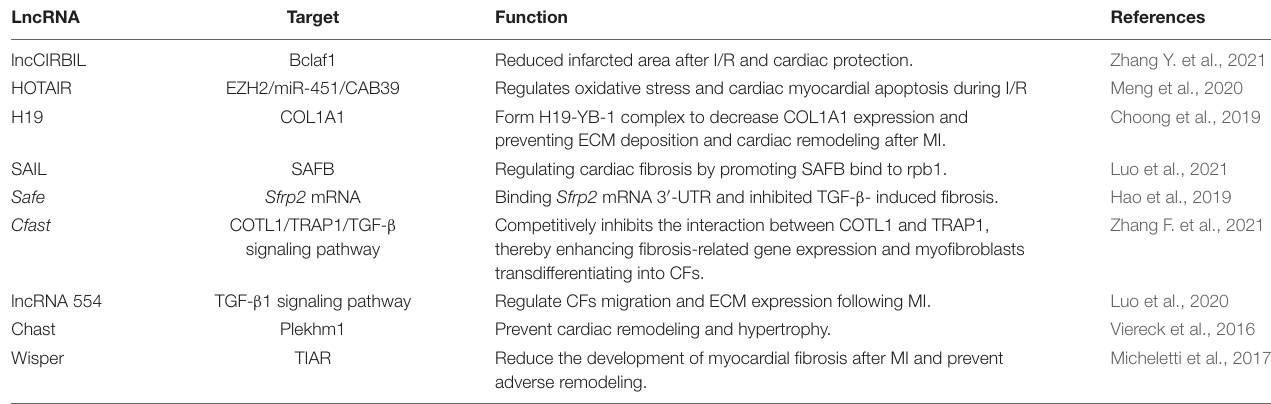
TABLE 3 | LncRNAs in secondary changes of myocardial infarction.